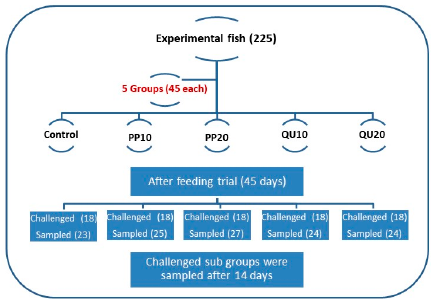
Figure 1. Schematic design of the experiment (groups, timing, and treatments). PP 10 : prickly pear fruit peel-supplemented group (10%), PP 20 : prickly pear fruit peel-supplemented group (20%), QU 10 : quinoa seeds—supplemented group (10%), QU 20 : quinoa seeds—supplemented group